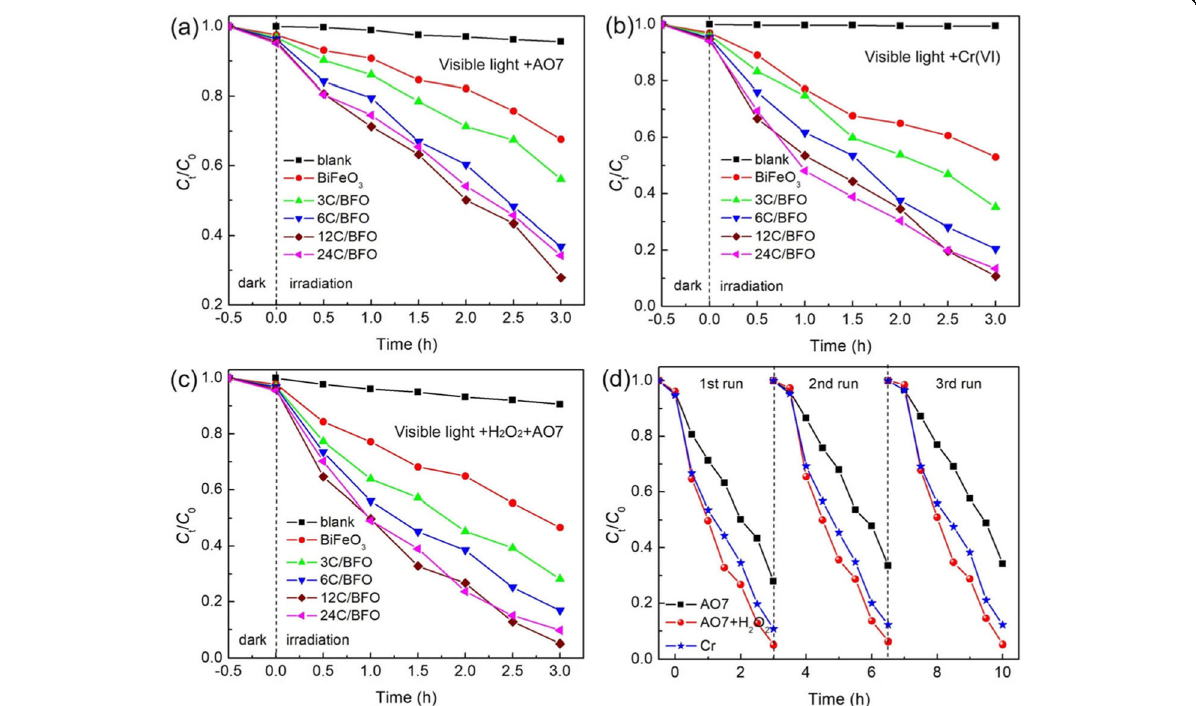
Fig. 8 a Photocatalytic degradation of AO7, b photocatalytic reduction of Cr(VI), and c photo-Fenton catalytic degradation of AO7 over BiFeO 3 and CQD/BiFeO 3 composites under visible light irradiation. d Recyclability of the 12C/BFO composite for photocatalytic degradation of AO7, photocatalytic reduction of Cr(VI), and photo-Fenton catalytic degradation of AO7 under visible light